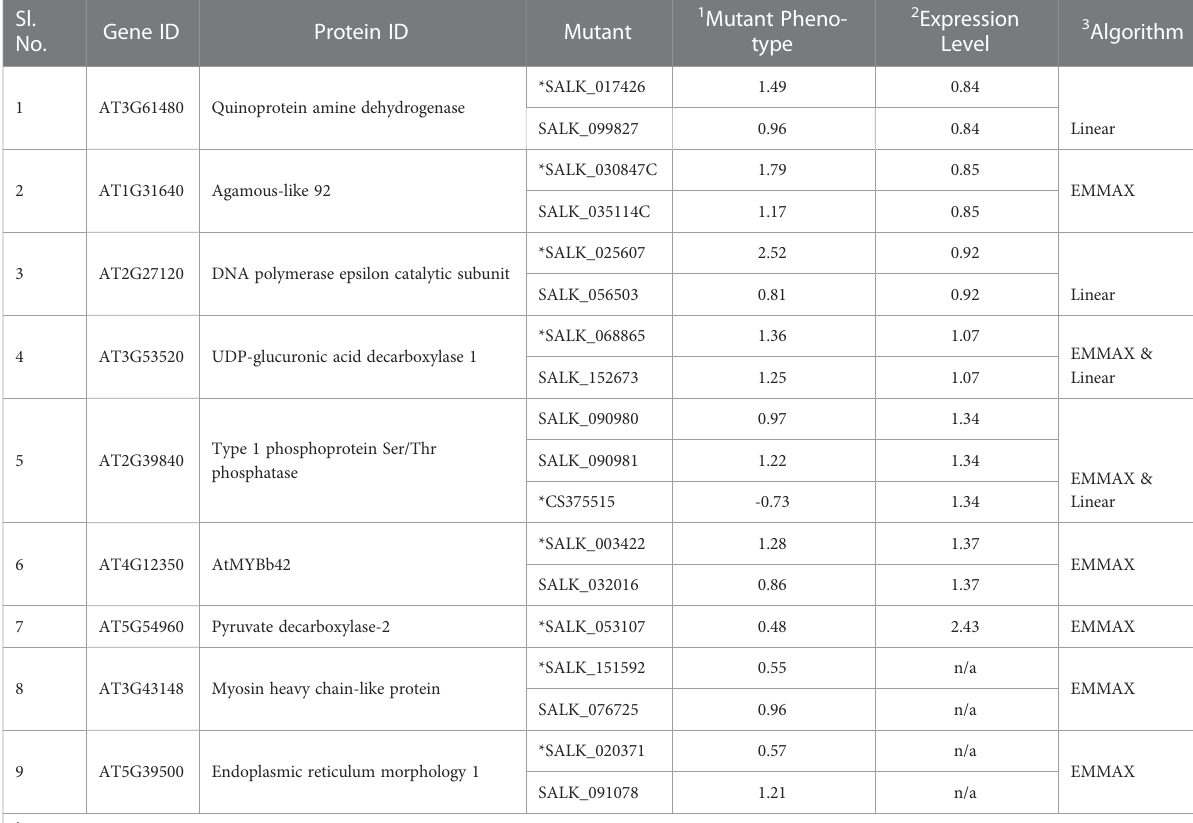
TABLE 2 The nine strong candidate genes involved in adapting Arabidopsis to cold stress. Sl.